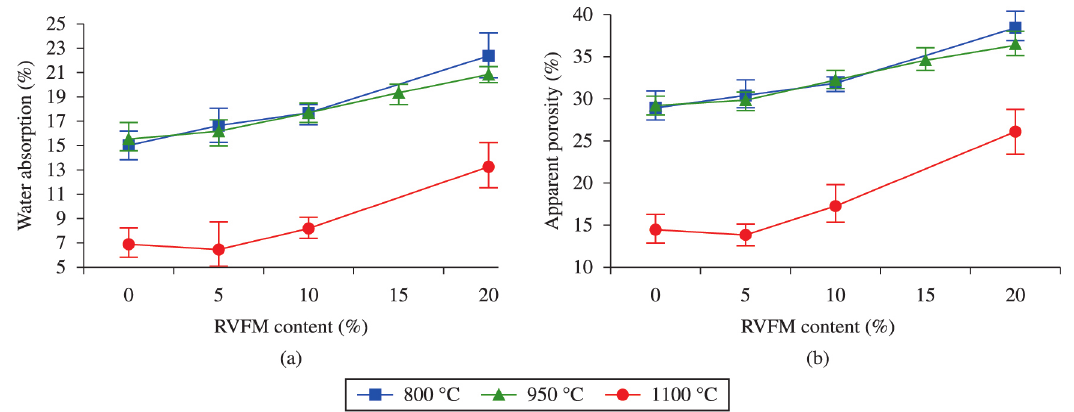
Figure 4. Effect of RVFM on water absorption (a) and porosity (b) of the ceramic block.